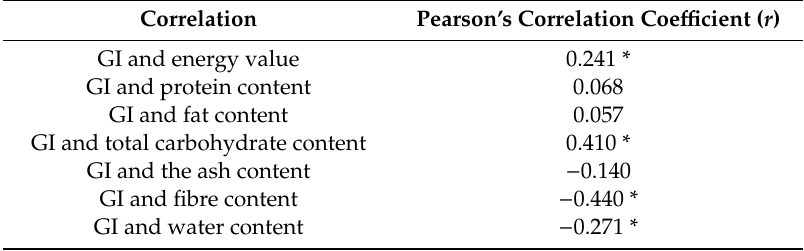
Table 3. Pearson’s correlation coe ffi cients between the glycaemic index (GI) and energy value, nutrient Table 3. Pearson's correlation coefficients between the glycaemic index (GI) and energy value, composition of the examined nutrient composition of the examined dishes.